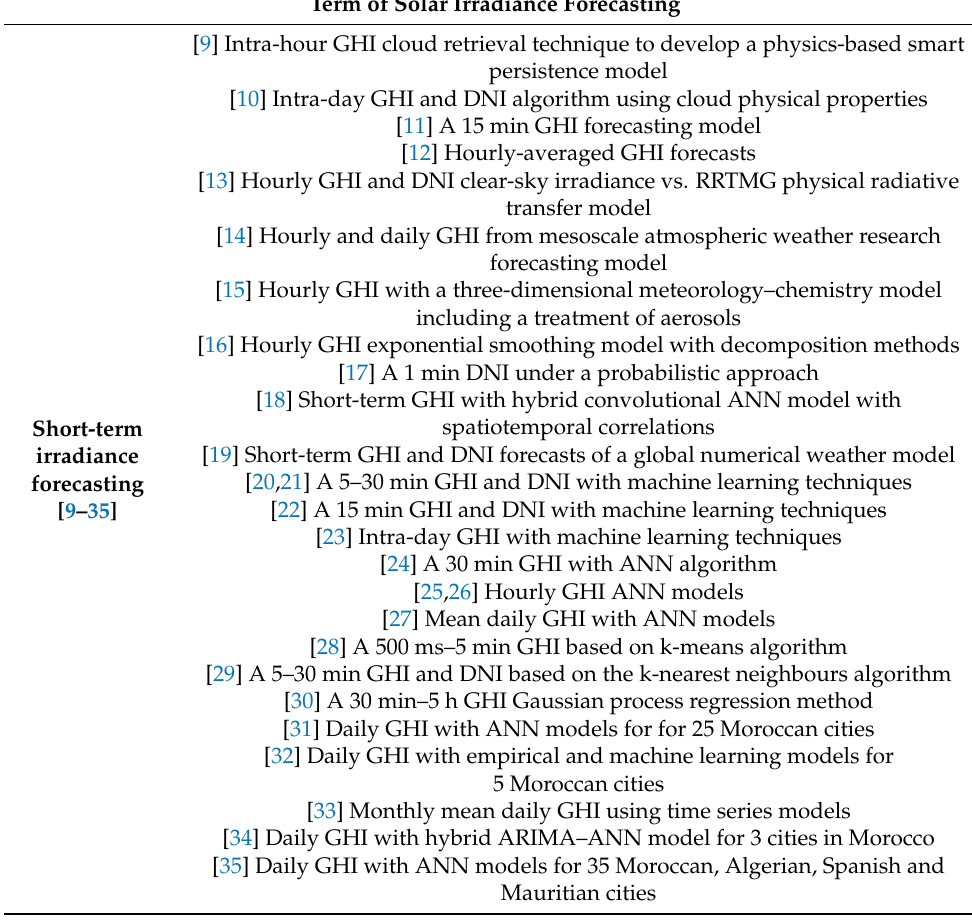
Table 1. Classification of the considered references. Source: own elaboration based on